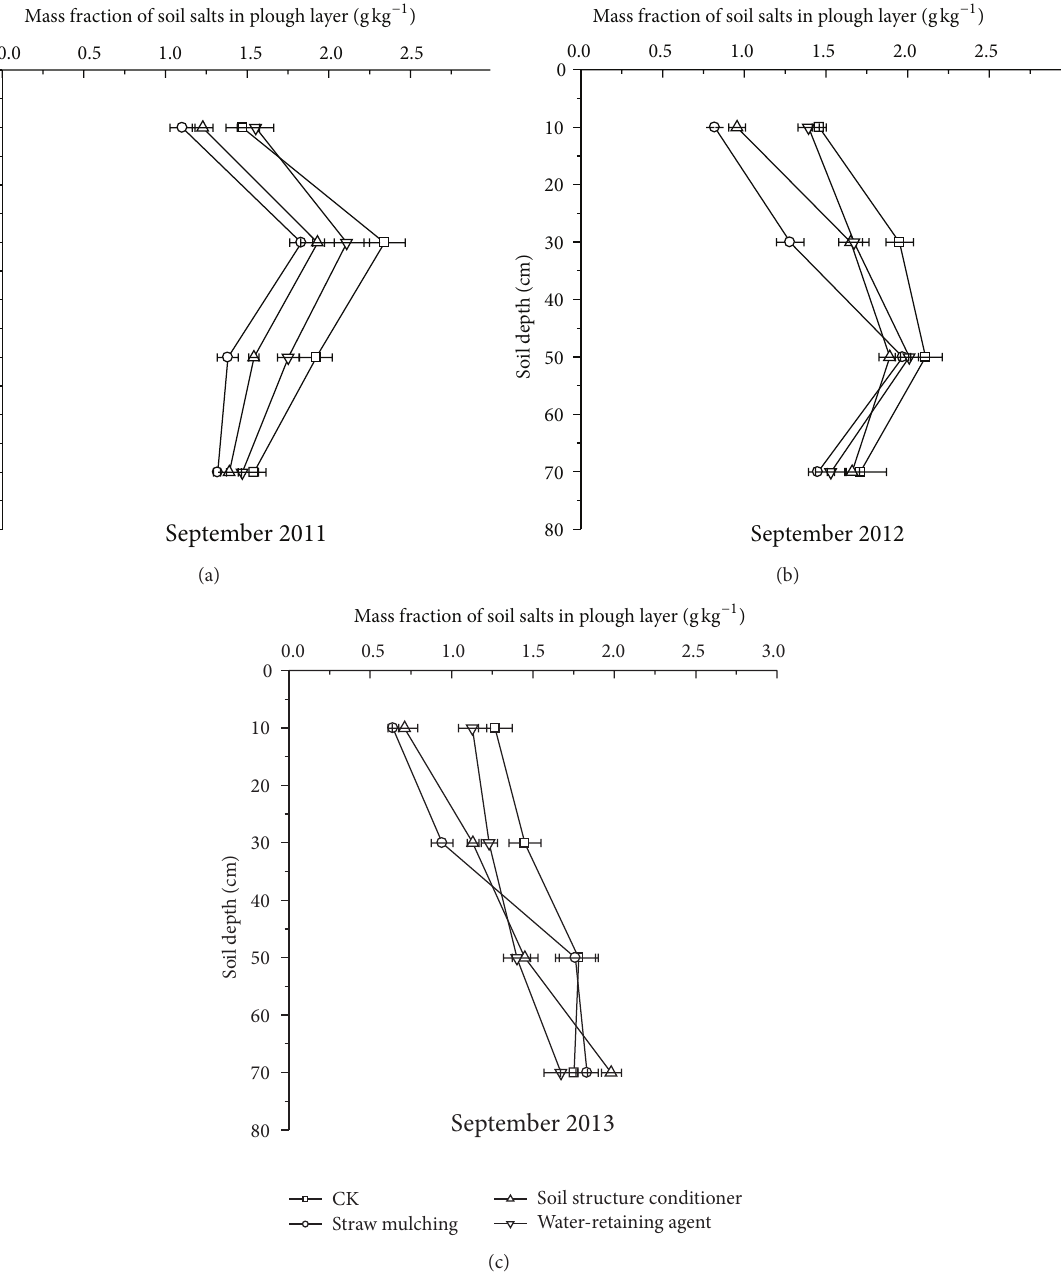
Figure 3: Profile distribution of soil salts in different experimental